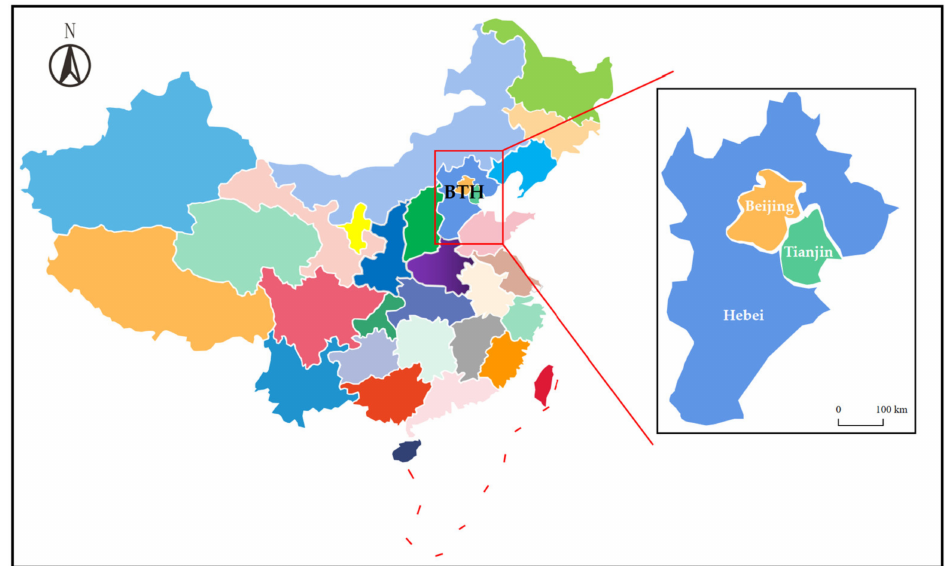
Figure 1. The location of the BTH region in China. The number of motor vehicles in the BTH region keeps increasing year after